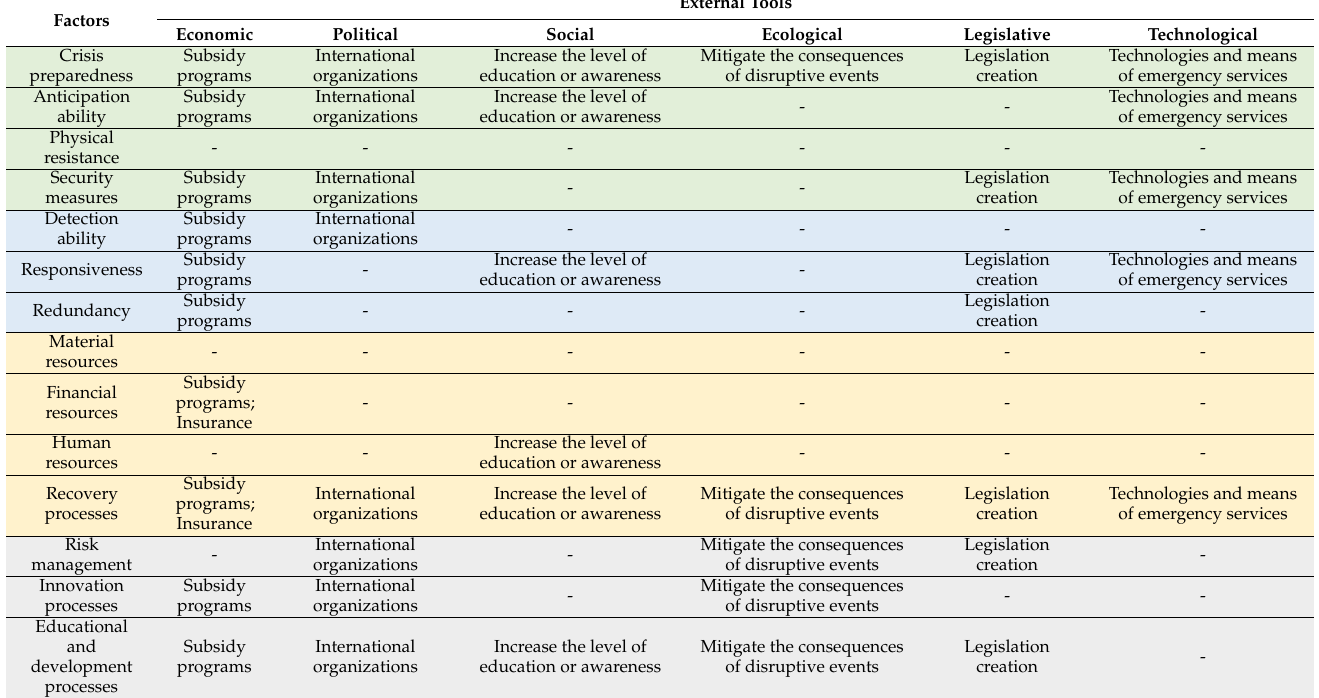
Table 4. Matrix for selecting external resilience-strengthening